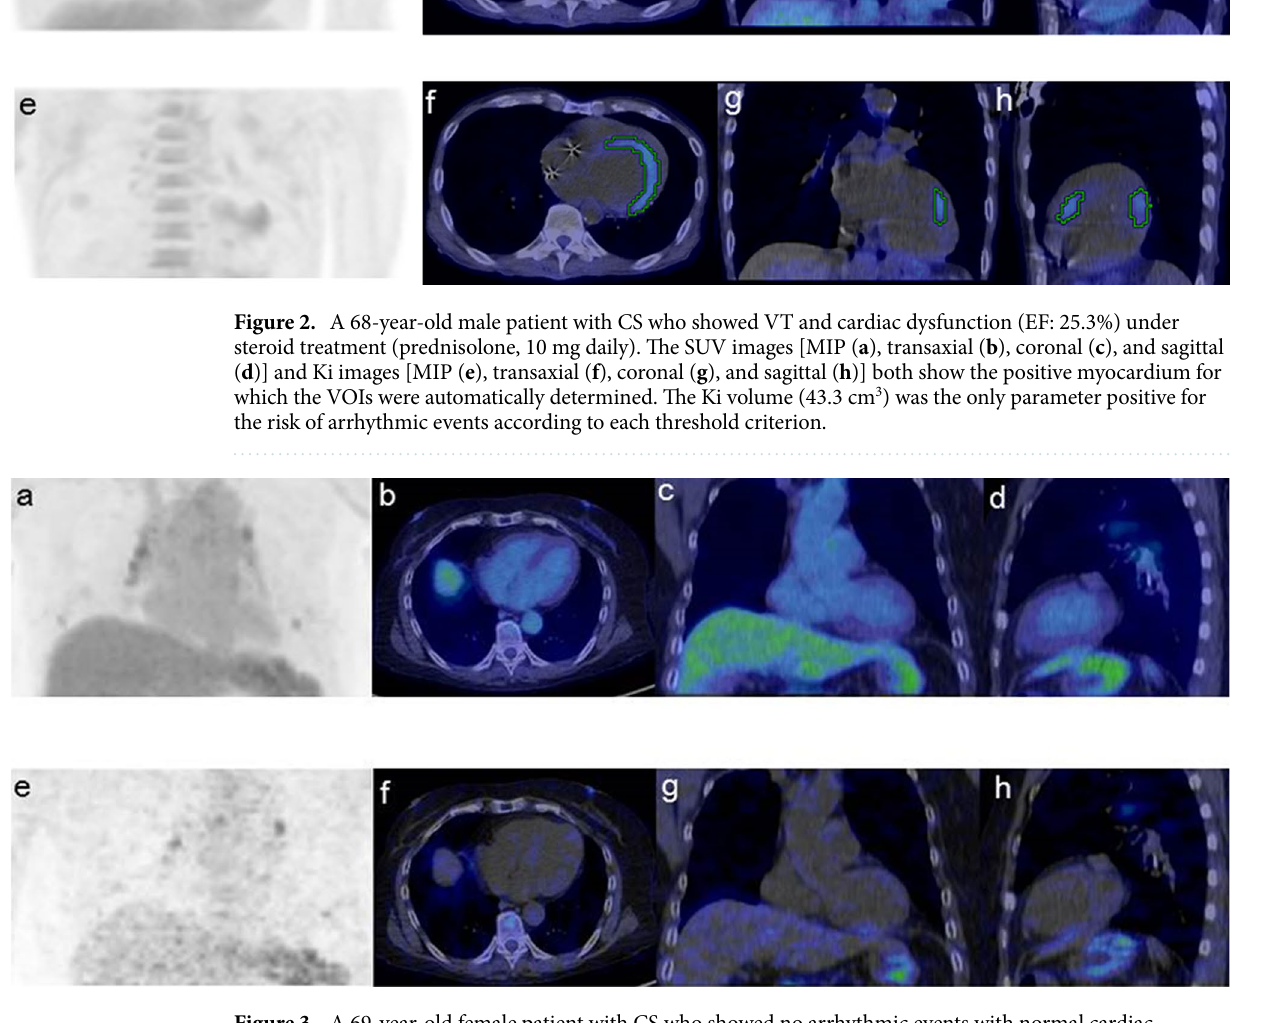
Figure 3. A 69-year-old female patient with CS who showed no arrhythmic events with normal cardiac function (EF: 70%) under steroid treatment (prednisolone, 10 mg daily). The SUV images [MIP ( a ), transaxial ( b ), coronal ( c ), and sagittal ( d )] and Ki images [MIP ( e ), transaxial ( f ), coronal ( g ), and sagittal ( h )] both show the negative